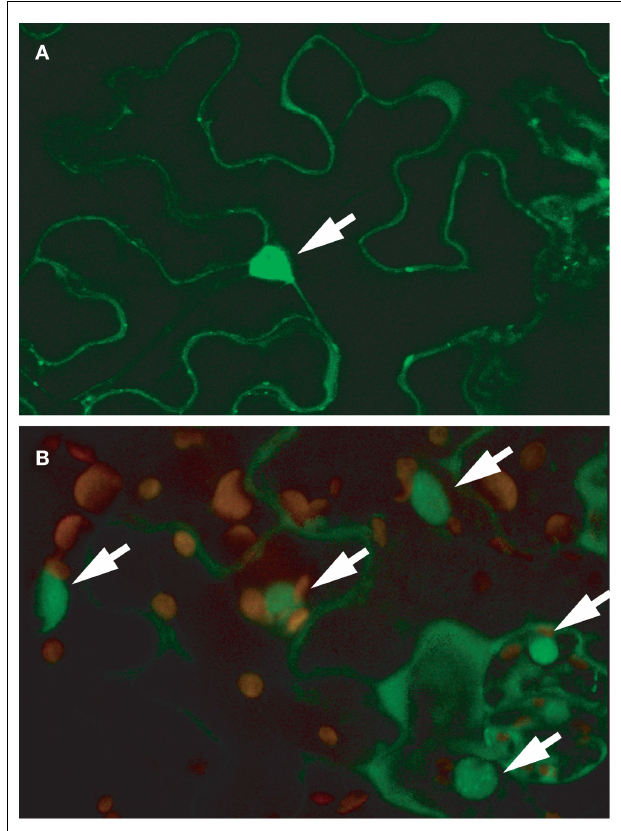
FIGURE 7 | RSR1–GFP localizes predominantly to the nucleus. Confocal microscopy images of leaf epidermal cells expressing an RSR1–GFP fusion protein under the control of a CaMV 35S promoter. (A) Single focal plane in the epidermis of a tobacco ( Nicotiana benthamiana ) leaf imaged 48h after infiltration with Agrobacterium tumefaciens suspension. (B) Leaf epidermis and parenchyma cells of a stably transformed Arabidopsis plant.The image shows a projection of 15 optical planes along the z -axis and an overlay of the GFP signal (green) with chlorophyll autofluorescence (red). GFP fluorescence was strongest in nuclei but also present in the cytoplasm. Nuclei are marked with